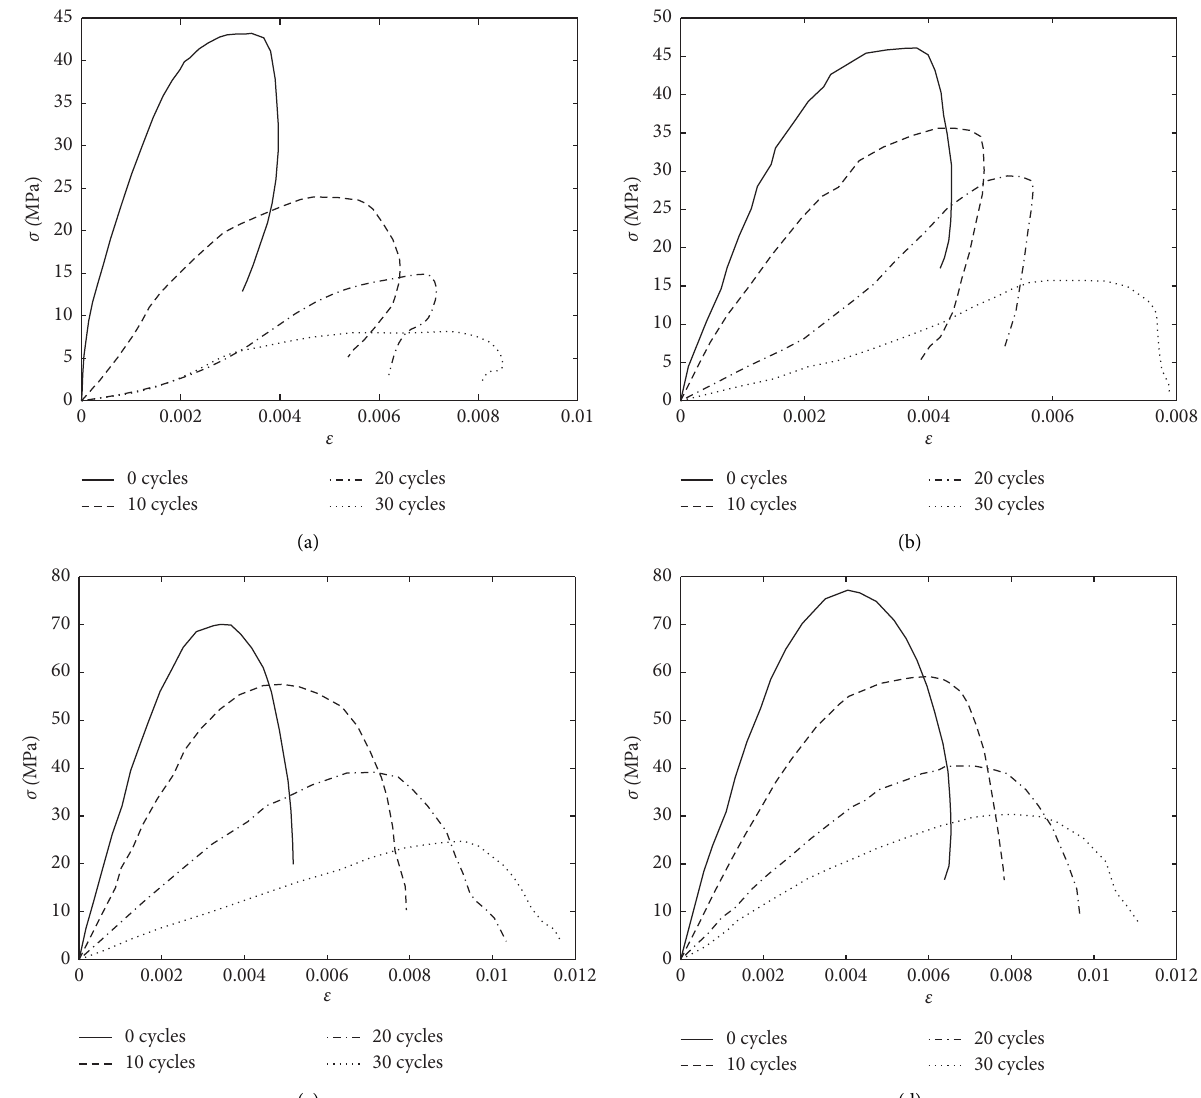
Figure 12: Stress-strain curves of different freeze-thaw damaged samples. (a) Axial pressure of 0MPa and (b) axial pressure of 5MPa and emission pressure of 0.07MPa. (c) Axial pressure of 0 MPa and (d) axial pressure of 5MPa and emission pressure of